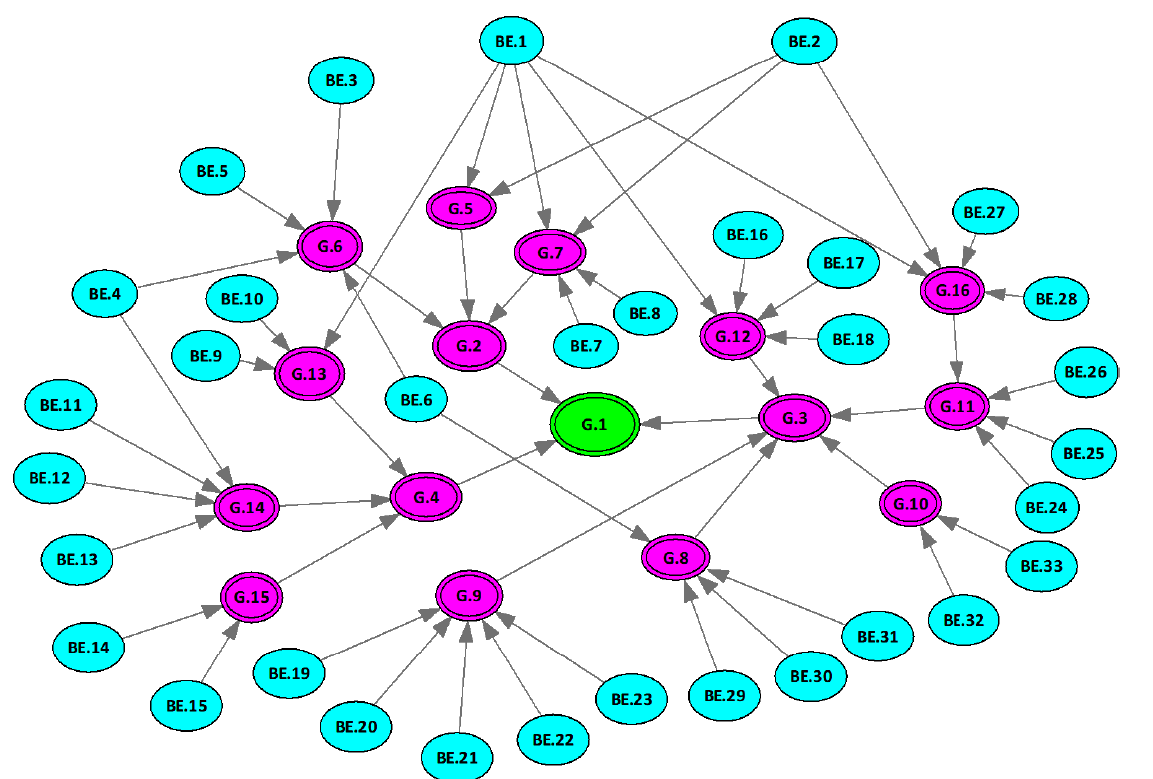
Figure 7. Bayesian network of the FFTA model in Figure 3.